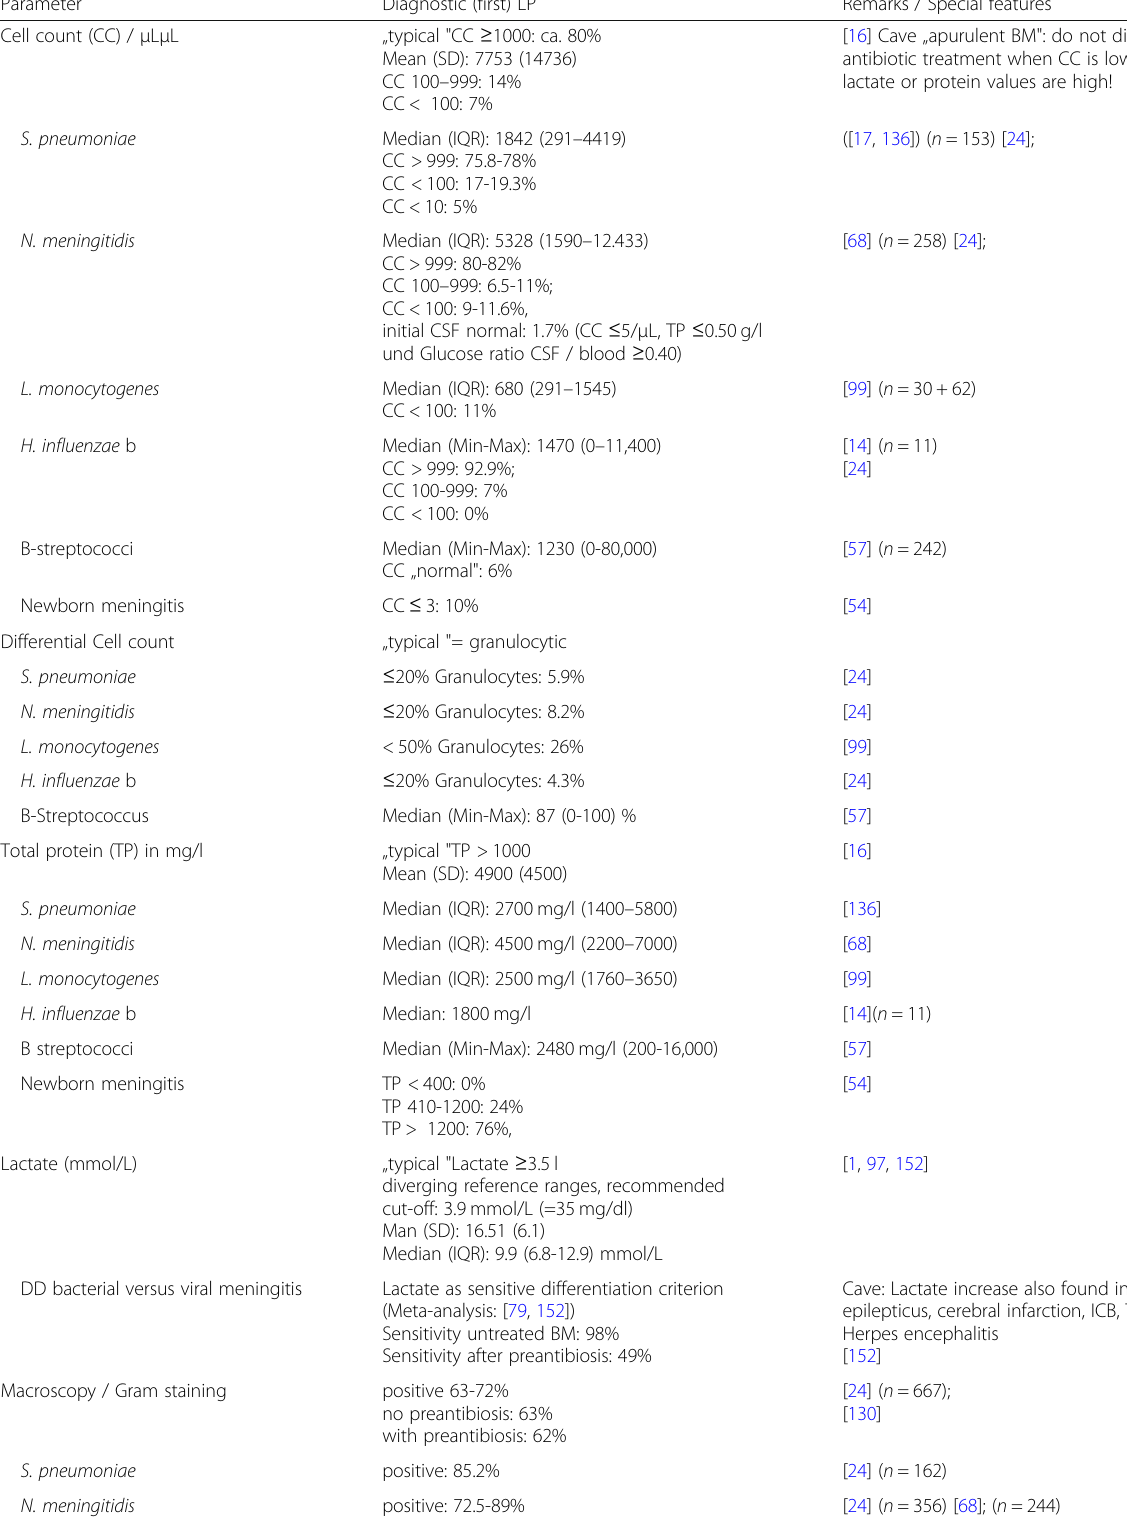
Table 5 Overview of diagnostically relevant routine parameters in acute bacterial meningitis (BM) and frequency of “ typical ” and “ atypical ” changes depending on the bacterial